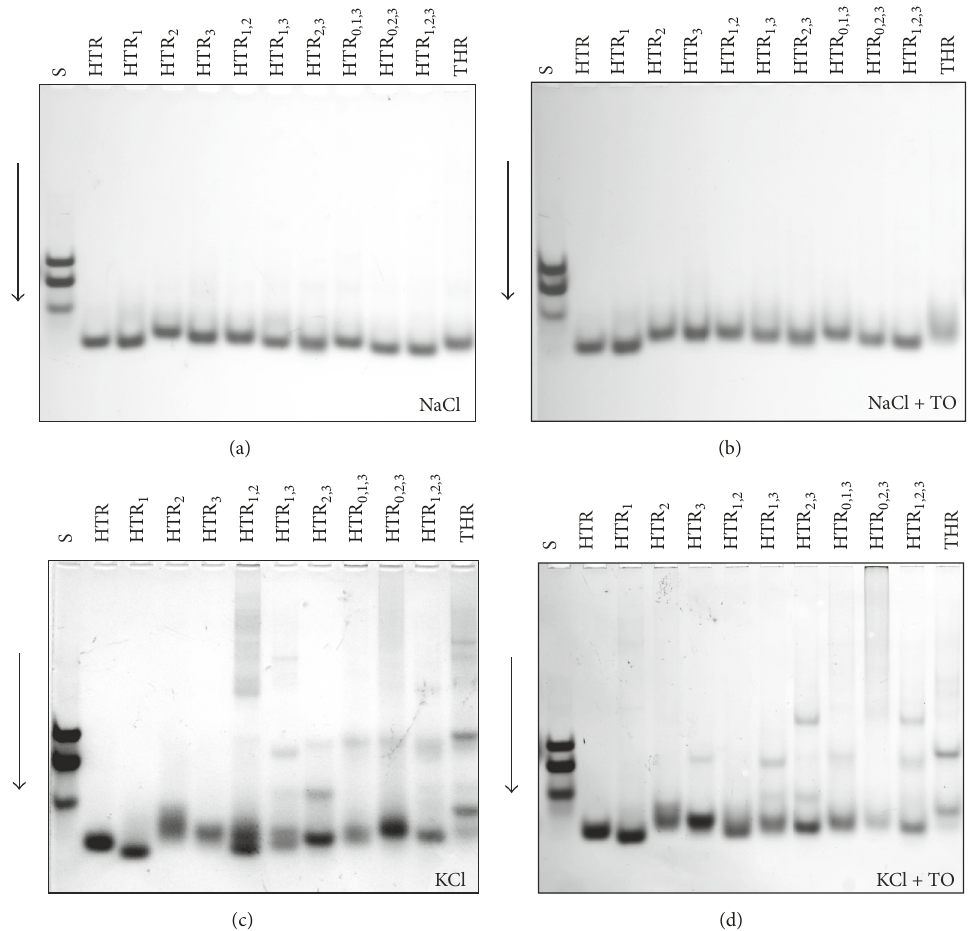
Figure 7: Electrophoretic records of studied DNA oligonucleotides. Electrophoretic gel and buffer contained 50 mM NaCl (a, b) and 50mM KCl (b, d), gels in (b) and (d) also contained 30 𝜇 M TO. 0.4 𝜇 L of DNA from 1mM stock solution was applied to each electrophoretic well ( ∼ 3 𝜇 M). The S-line represents the mobility of the mixture of oligonucleotides: d ( AC ) 9 , d(AC) 14 , and d(AC) 18